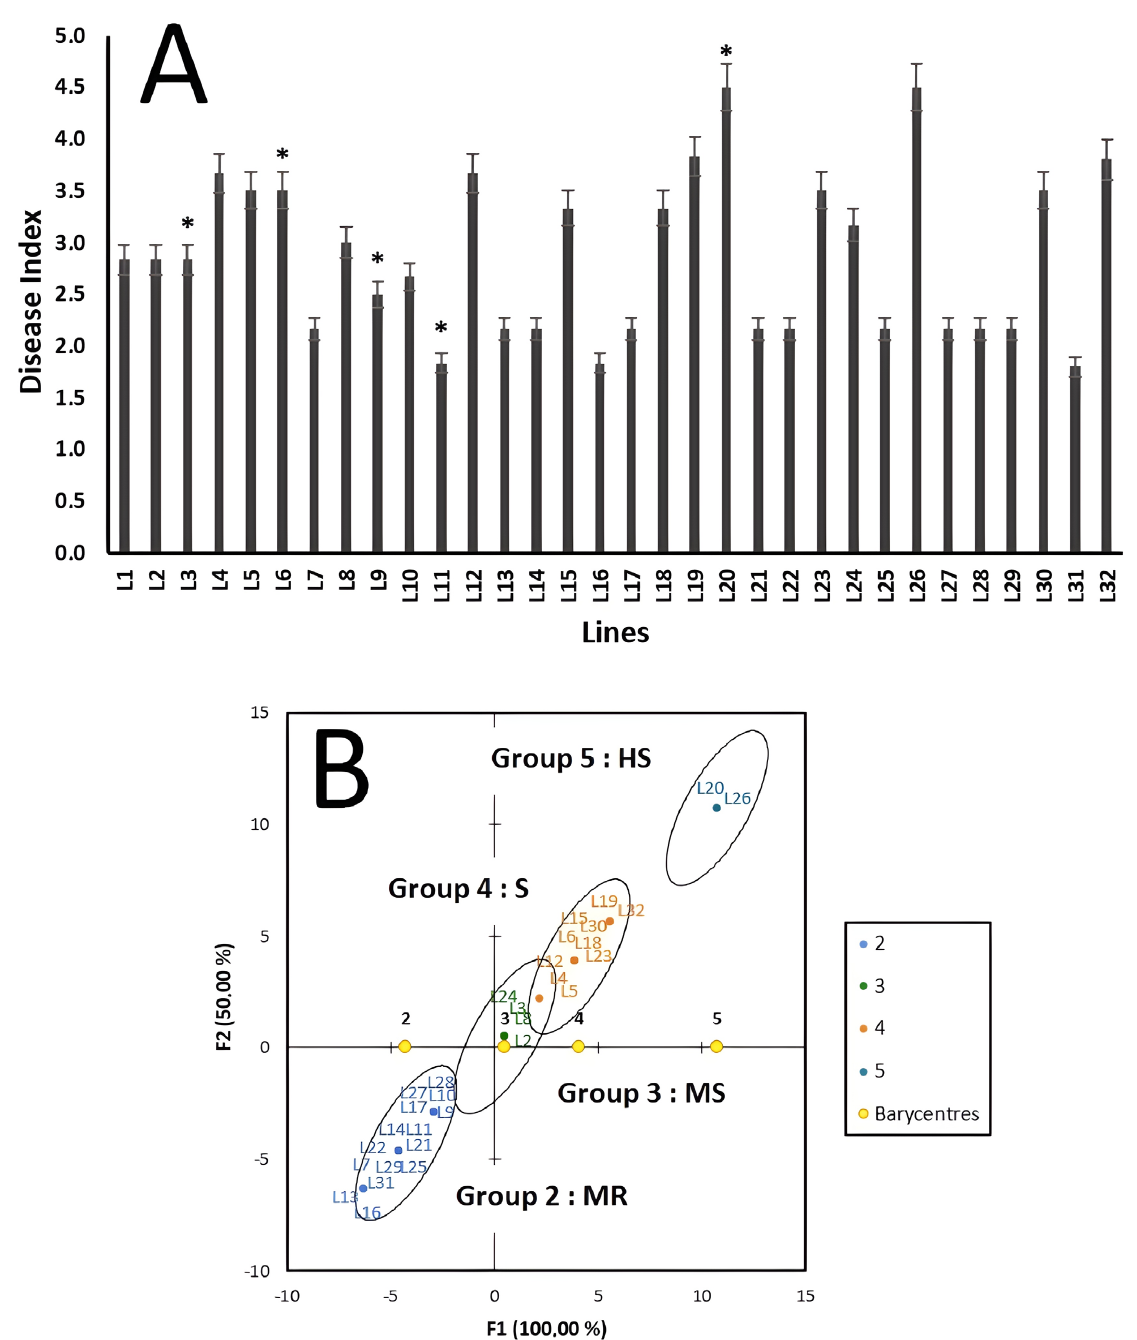
Figure 3. ( A ) Crown rot disease index of 32 spring wheat lines (including six check lines) of Fusarium pseudograminearum in Eskişehir. Asterisks (*) represent homogeneous groups based on the protected least significant difference test for each variable at p < 0.001. Error lines on bars represent the standard error (n = 6). ( B ) Discriminant Factorial Analysis (AFD) showed the population structure for a set of 32 lines from CIMMYT’s spring wheat nursery based on their resistance reaction against F. pseudograminearum in growth room conditions. Numbers represent resistance reaction: 2: moder- ately resistant; 3: moderately susceptible; 4: susceptible; 5: highly susceptible. Yellow points represent the barycenter’s defining